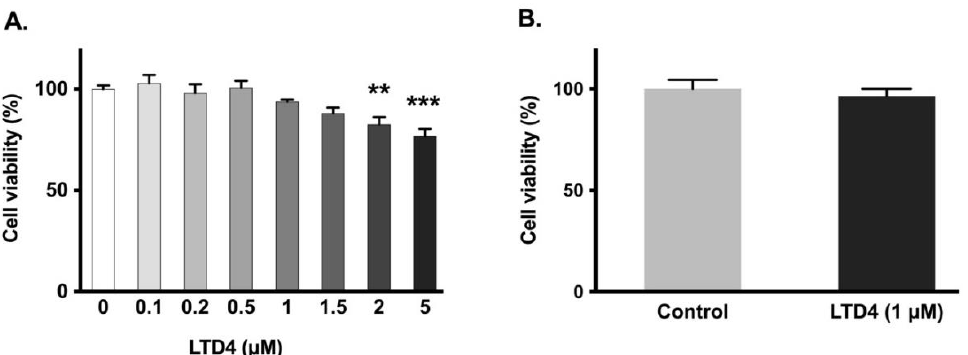
Figure 2. Effect of LTD4 exposure for 24 h on cell viability. ( A ) Measurement of cell viability by MTT assay ( n = 6, Dunnett’s multiple comparison test). ( B ) Measurement of cell viability by trypan blue assay ( n = 6, unpaired t-test). Values are represented as means ± SEM. ** p < 0.01, *** p < 0.001 vs. 0 µM.